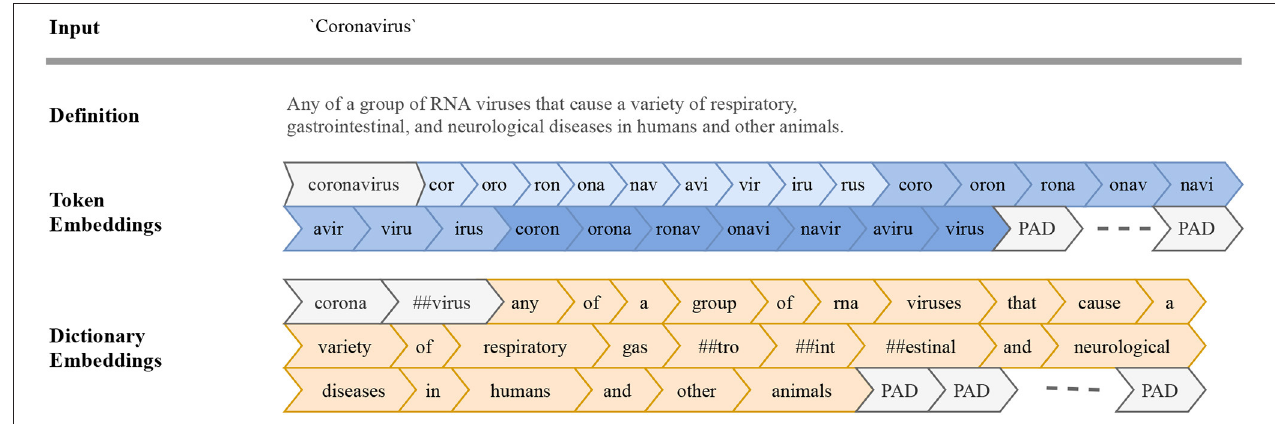
FIGURE 2 | Input sequence embeddings. We use two encoding schemes to prepare input sequences for our models: token embeddings (blue) and dictionary embeddings (orange) for our Token and Dictionary models, respectively. Given an input word (e.g., “coronavirus,”) we first break the input token into character-level n -grams ( n ∈ { 3,4,5 } ). The resulting sequence of n -grams along with the original word at the beginning of the embeddings are used in our Token model. Sequences shorter than a specified length are appended with PAD, a padding token ensuring a universal input size. For our Dictionary model, we first look up a dictionary